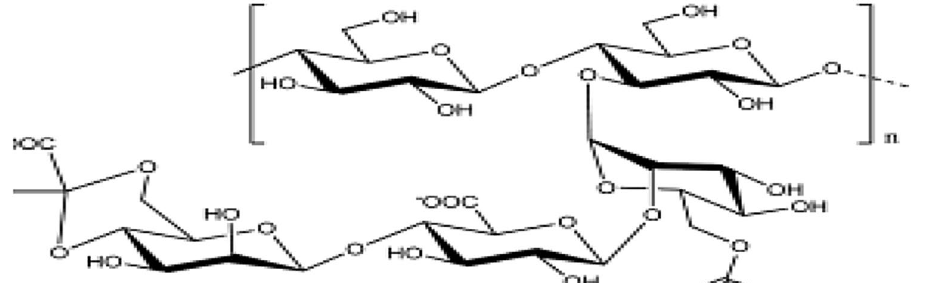
Fig. 2 Chemical structure of xanthan